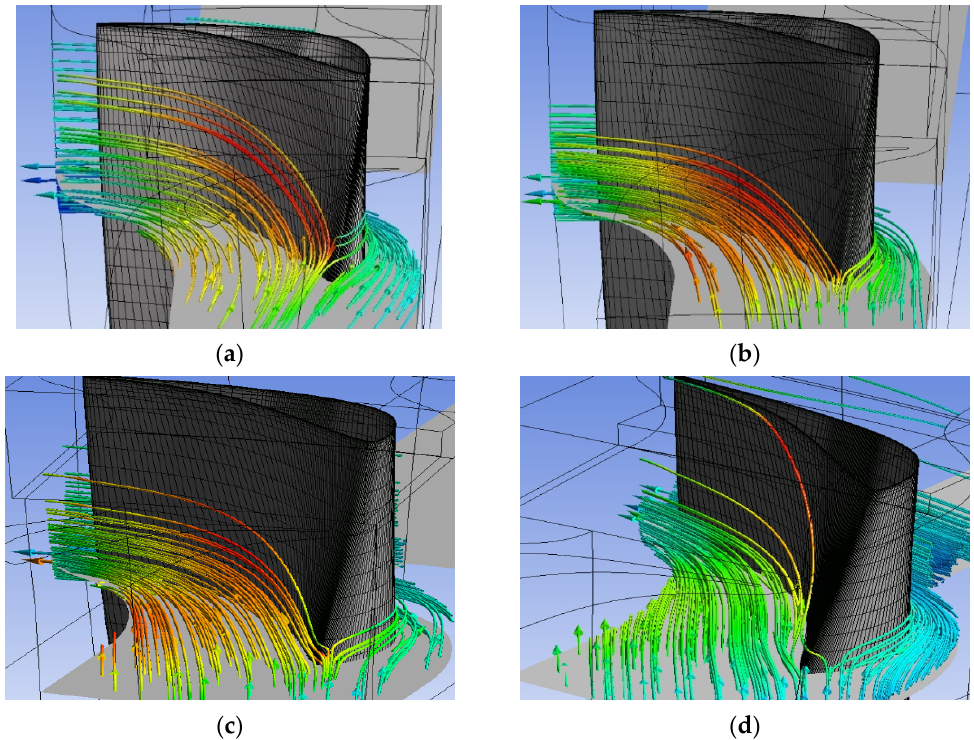
Figure 5. Details of streamlines on the bucket leading edge at the mid radius: ( a ) v1; ( b ) v2; ( c ) v3; and ( d ) v4.